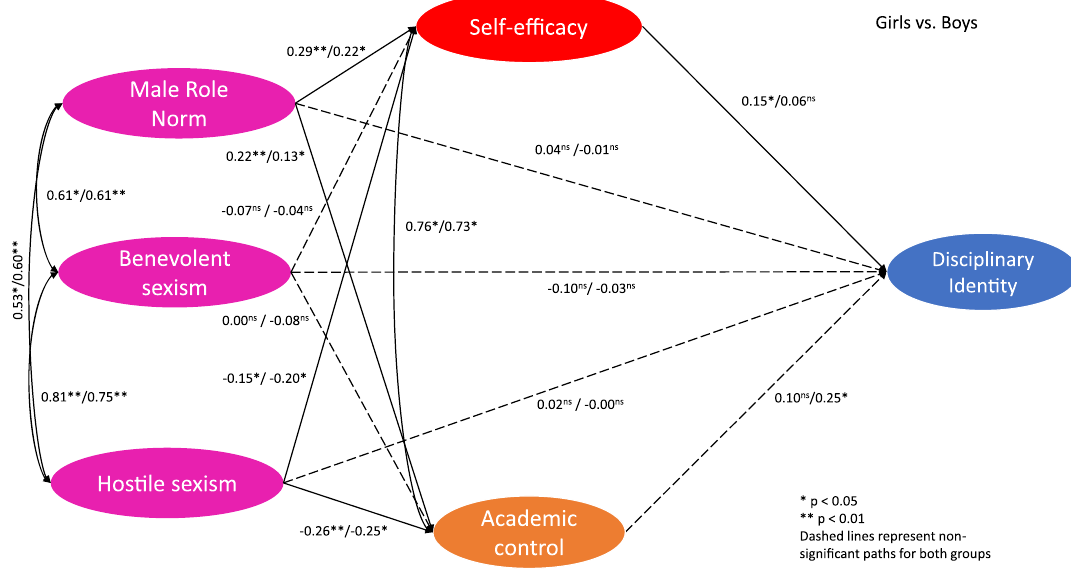
FIG. 3. Path analysis showing the relationships between gender stereotypes, self-efficacy, perceived academic control, and disciplinary identity for girls and boys involved in the study. Results are reported in the format: